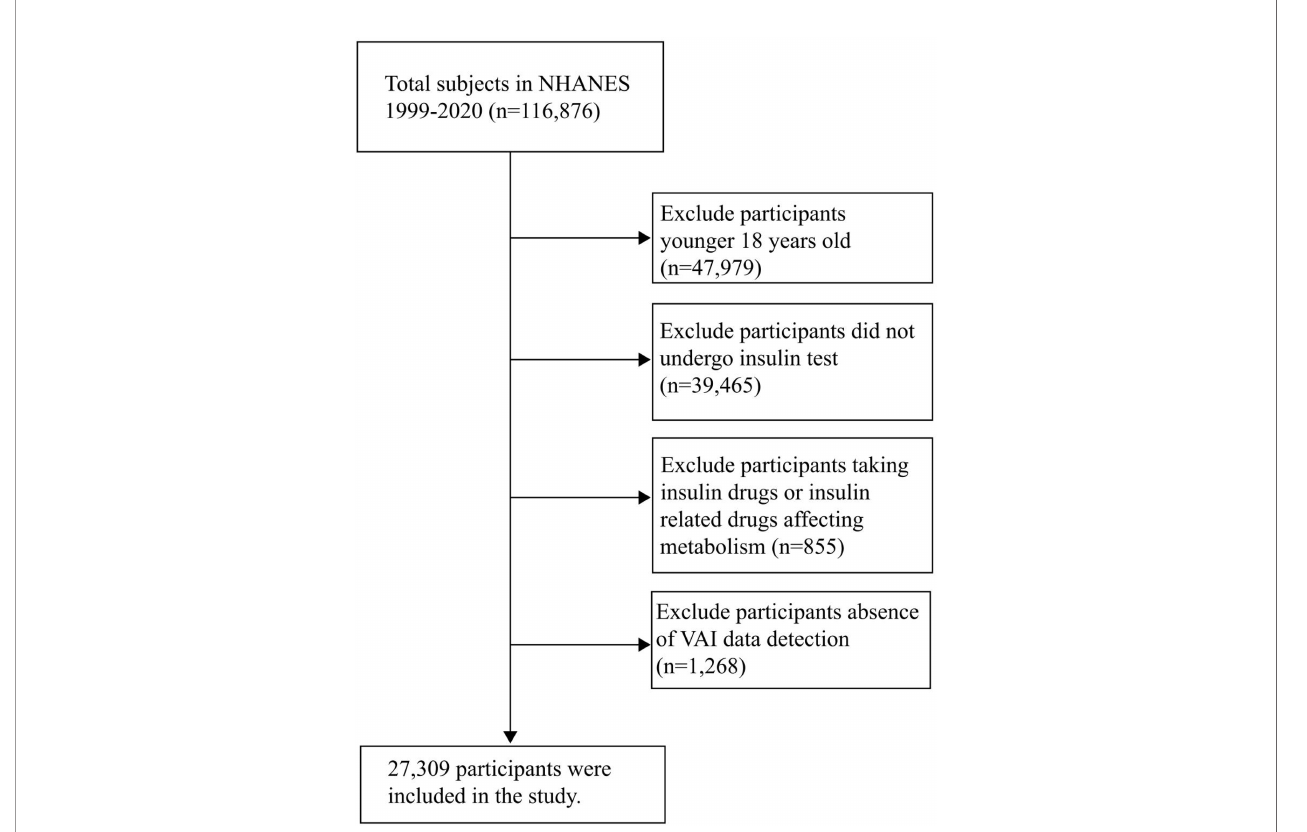
FIGURE 1 | Flowchart of patient